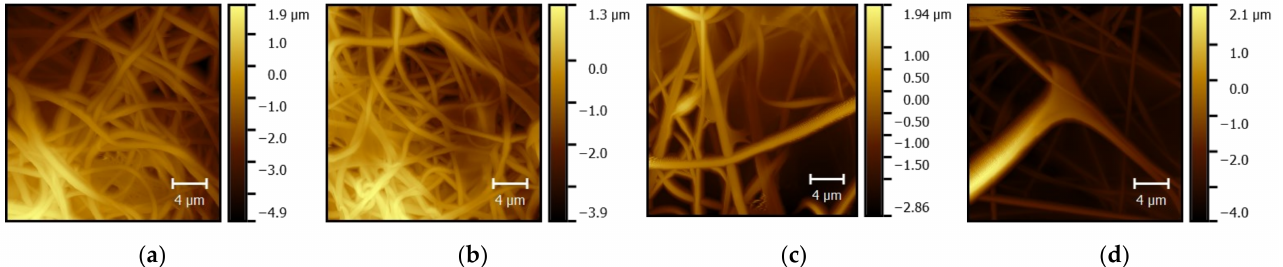
Figure 1. Original atomic force microscopy (AFM) images ( a – d ), taken on different positions of an electrospun nanofiber mat, as explained in detail in the text.